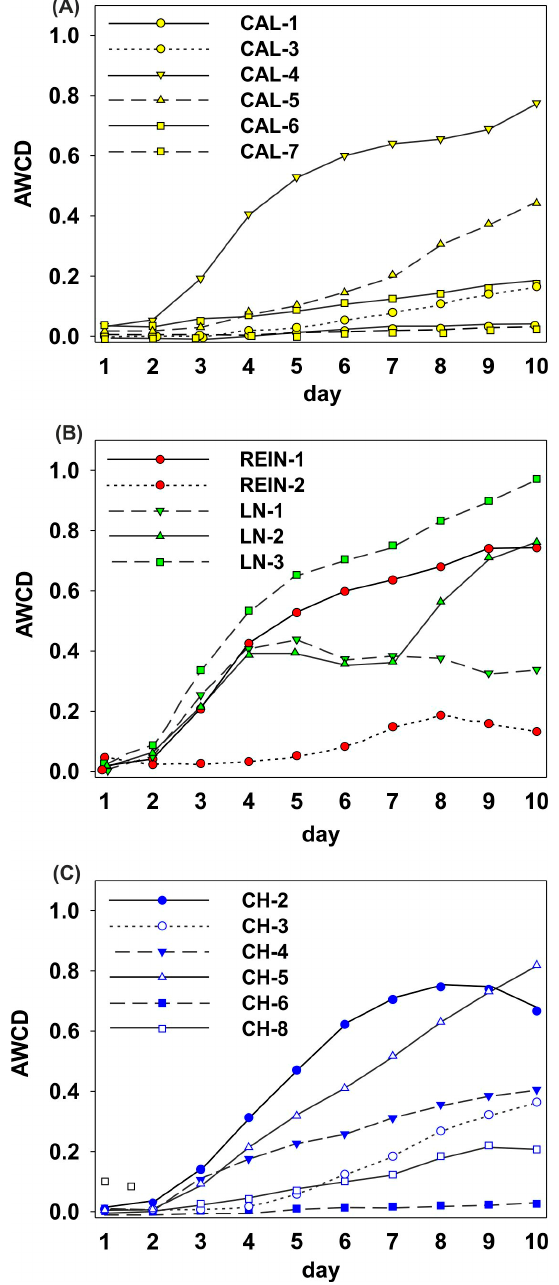
Figure 3. The kinetic curves of AWCD (average well color development) for different soil microbial communities ( A − C ).